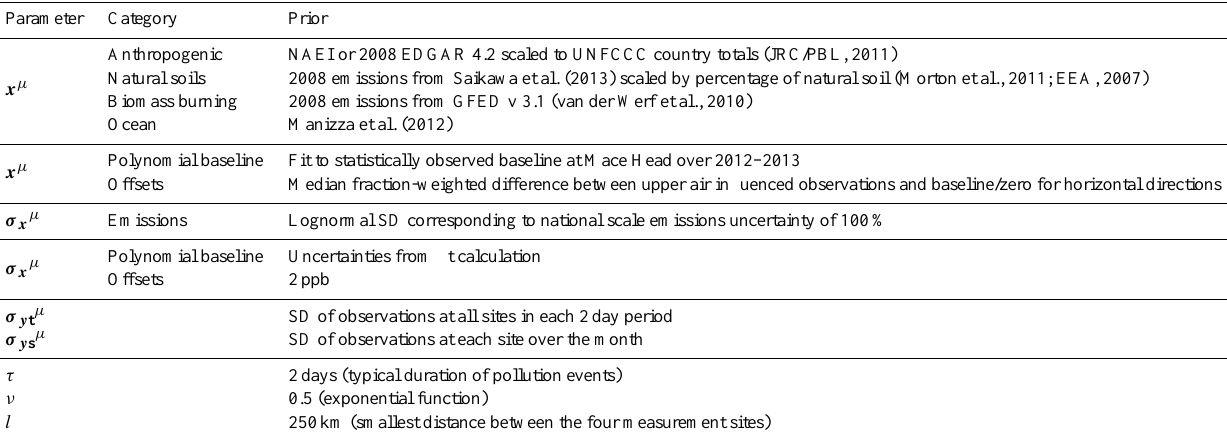
Table 3. A priori emissions of major source sectors in Tgyr − 1 and percent contribution to UK emissions Species Prior January emissions July emissions (% of total) Anthropogenic, CH 4